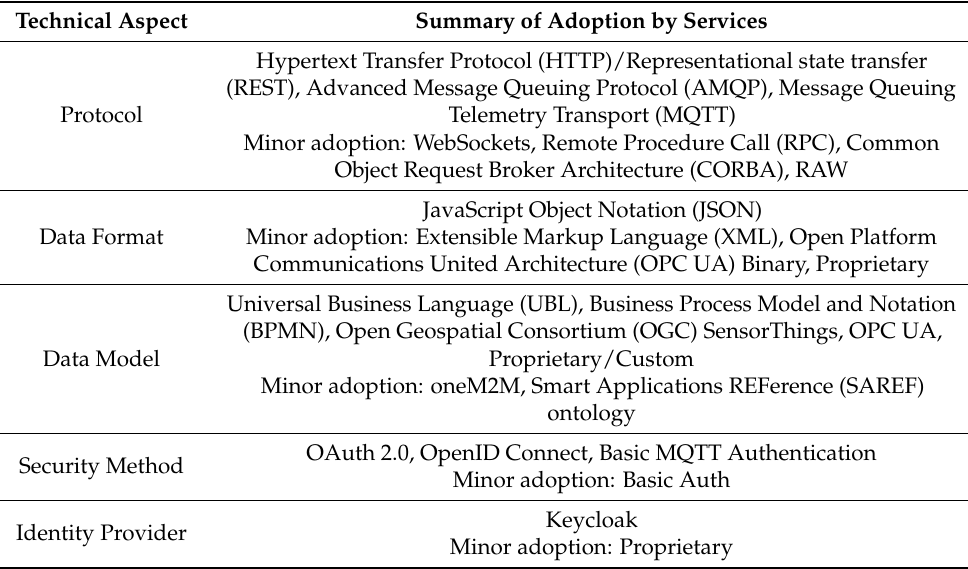
Table 1. Summary of the technical profiles of the base platforms. Technical Aspect Summary of Adoption by